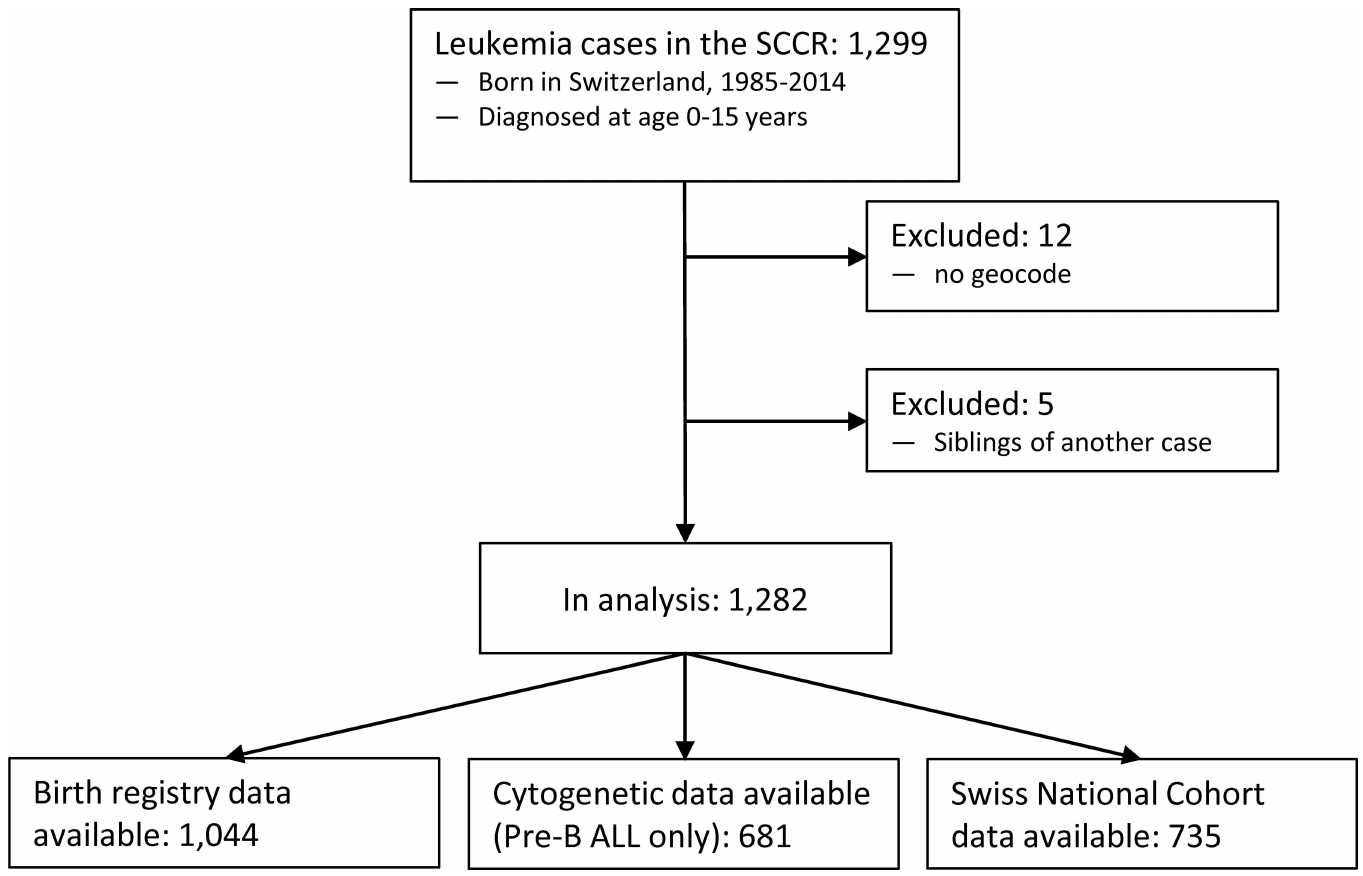
Fig 1. Flow chart of study